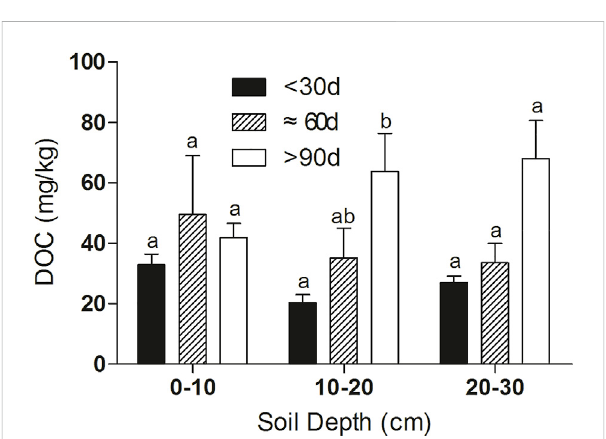
FIGURE 7 DOC value at different soil layers and CDE levels. The values of DOC with the same lowercase letter do not differ signi fi cantly ( p > 0.05) based on Dunn ’ s multiple comparison